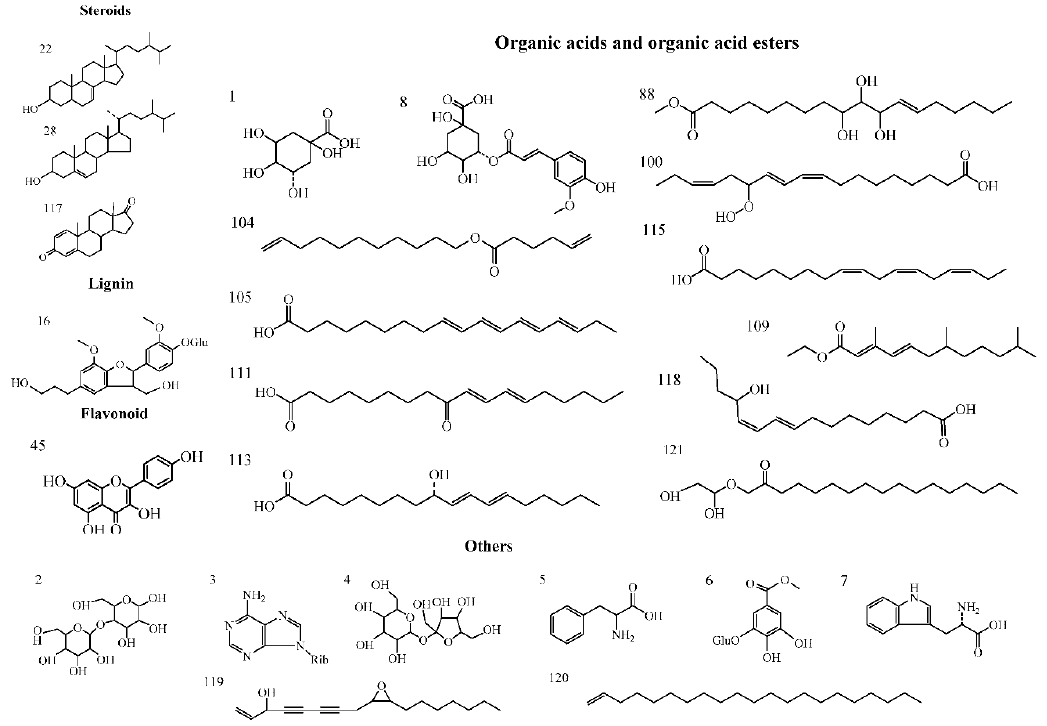
Figure 2. Chemical structures of compounds identified in FgAG and WsAG.